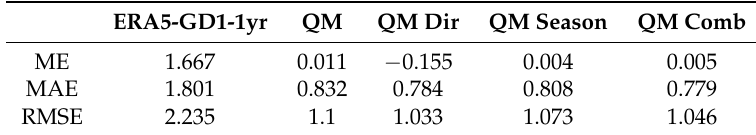
Table 5. Error metrics of ERA5’s closest grid point’s wind speed series and its calibrations against the measurements for a 1-year period, expressed in m/s.